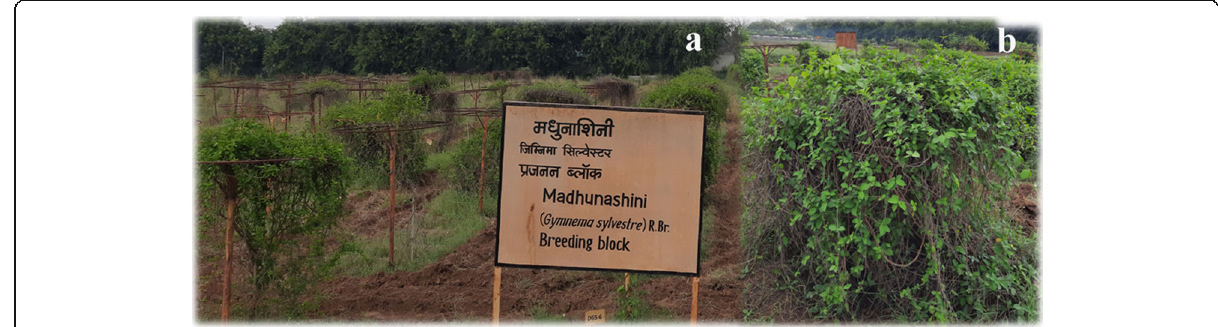
Fig. 1 a Gymnema sylvestre R. Br. breeding block and b voucher specimen of the